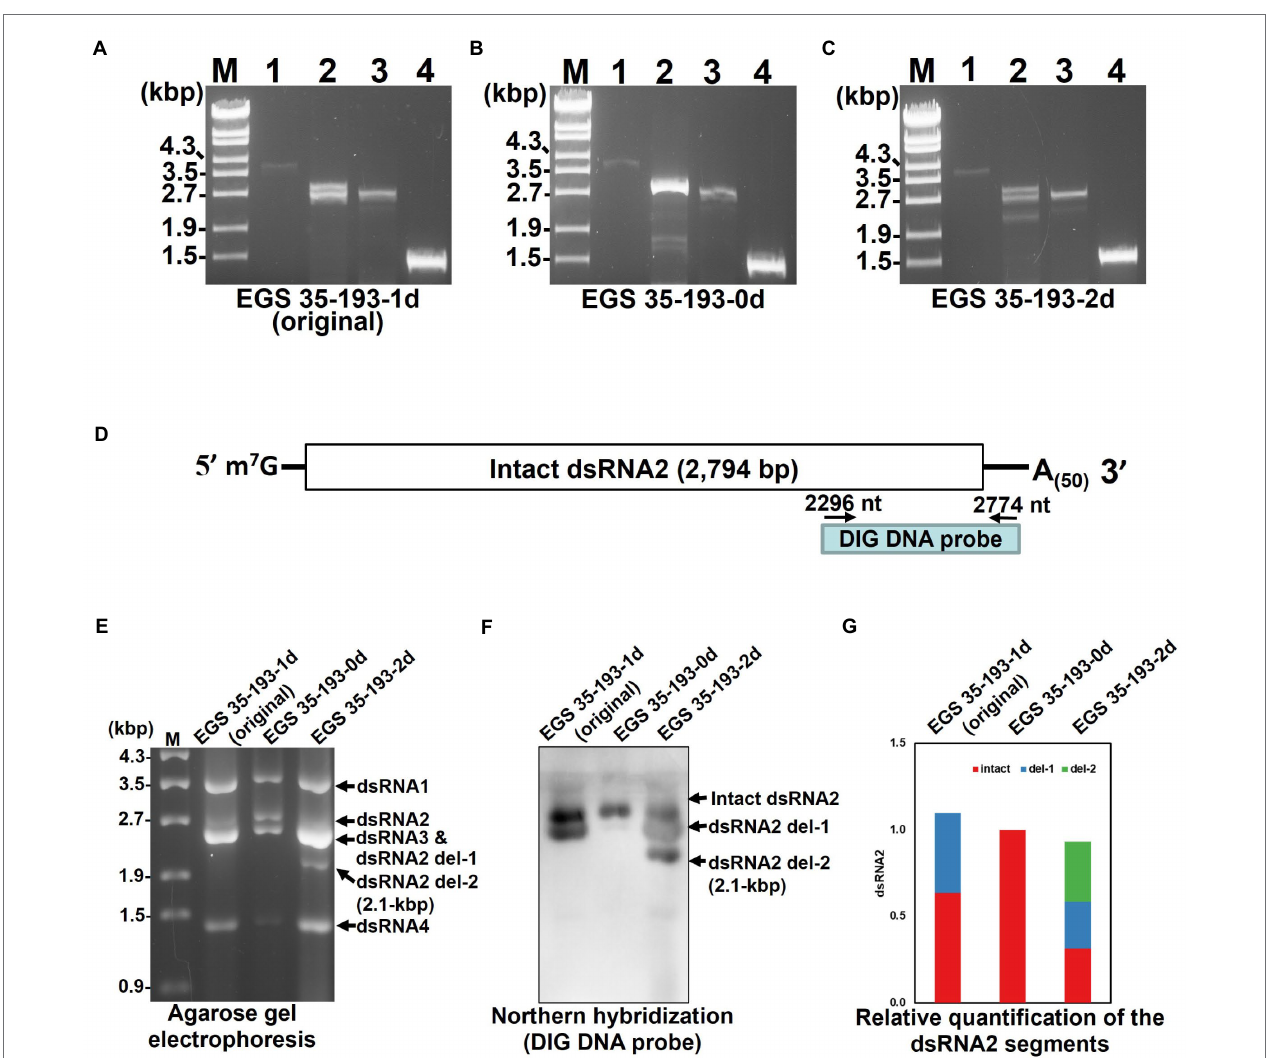
FIGURE 5 | Analysis of the AaV1 dsRNA2-associated segments in virons purified from the three AaV1-infected isolates. (A-C) RT-PCR detection of the full-length dsRNA1–4 segments in EGS 35–193-1d (A) , EGS 35–193-0d (B) , and EGS 35–193-2d (C) . RT-PCR was performed with the four primer pairs ( Figure 2C ; Supplementary Table S1 ) designed to amplify the full-length dsRNA1–4 segments. The RT-PCR products were separated in 1.0% agarose gels with EtBr (0.5 μ g/ ml) at 50 V for 1 h. Lane designation: M, 250 ng of λ -EcoT14I-digested DNA marker; 1, dsRNA1; 2, dsRNA2; 3, dsRNA3; 4, dsRNA4. (D) Position of the DIG DNA probe used to detect the 3 ' region of AaV1 dsRNA2 in the northern hybridization experiment. The DIG DNA probe was synthesized using the probe synthesis primer pair ( Supplementary Table S1 ). (E) Agarose gel electrophoresis of dsRNA genomes extracted from the purified virus particles of the three AaV1-infected isolates. These AaV1 dsRNAs were separated in a 1.0% agarose gel with EtBr (0.5 μ g/ml) at 18 V for 20 h. Lane M, 250 ng of λ -EcoT14I-digested DNA marker. (F) Northern hybridization to detect the AaV1 dsRNA2-associated segments. After agarose gel electrophoresis, the dsRNA genomes were denatured and blotted onto a nylon membrane, and probed with the DIG DNA probe. (G) Relative quantification of the three dsRNA2 segments, intact, del-1 and del-2, following northern hybridization (F). The total signal in each lane was normalized using the amount of dsRNA 1, following agarose gel electrophoresis (E). Quantification of individual bands was performed using